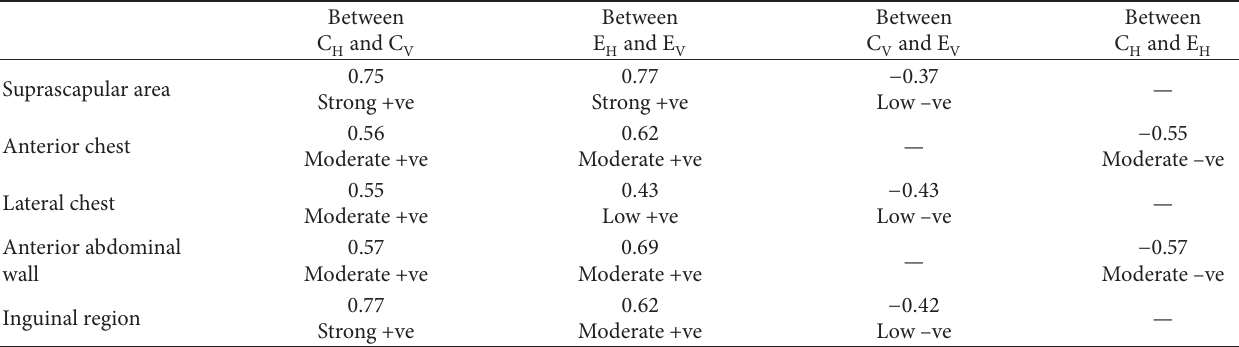
r = Spearman’s correlation coefficient; +ve: positive correlation; − ve: negative correlation. (C H : collagen in horizontal, C V : collagen in vertical, E H : elastic in horizontal, and E V : elastic in vertical